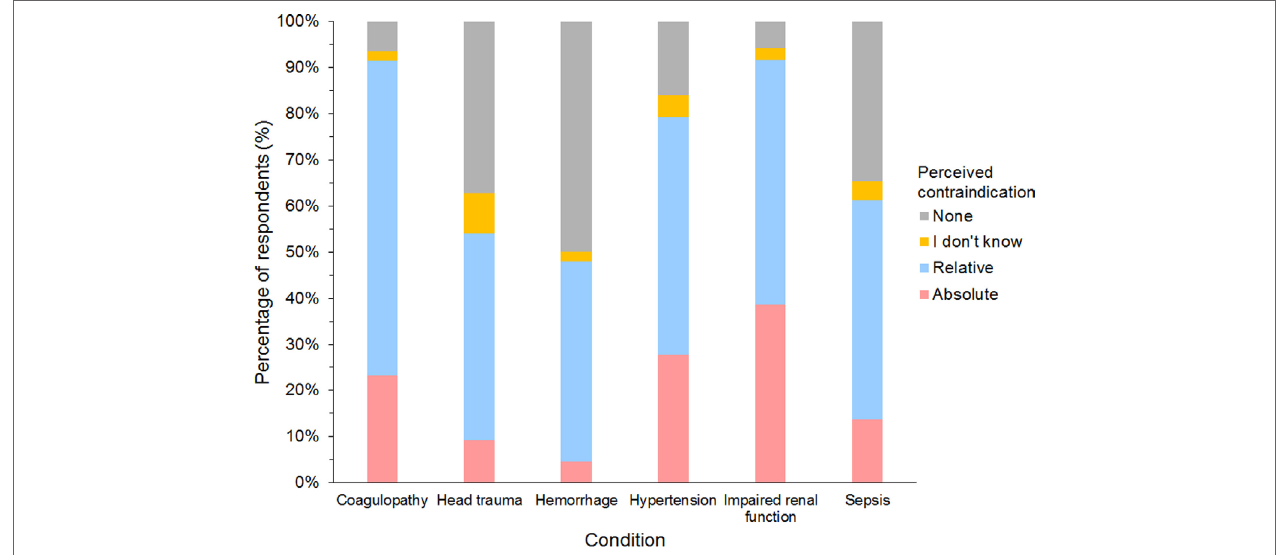
FigUre 12 | Frequency chart showing relative and absolute contraindications for the use of hydroxyethyl starch perceived by 632 survey